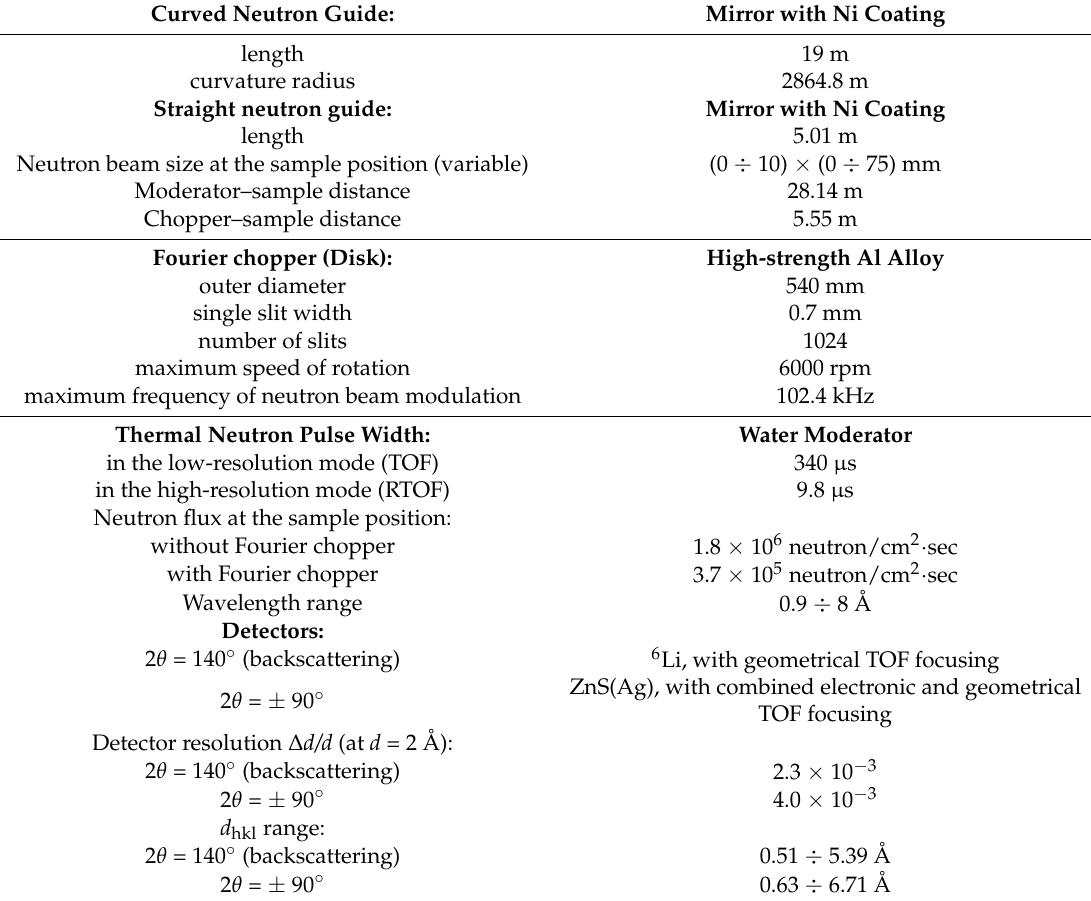
Table 1. Main parameters of the FSD